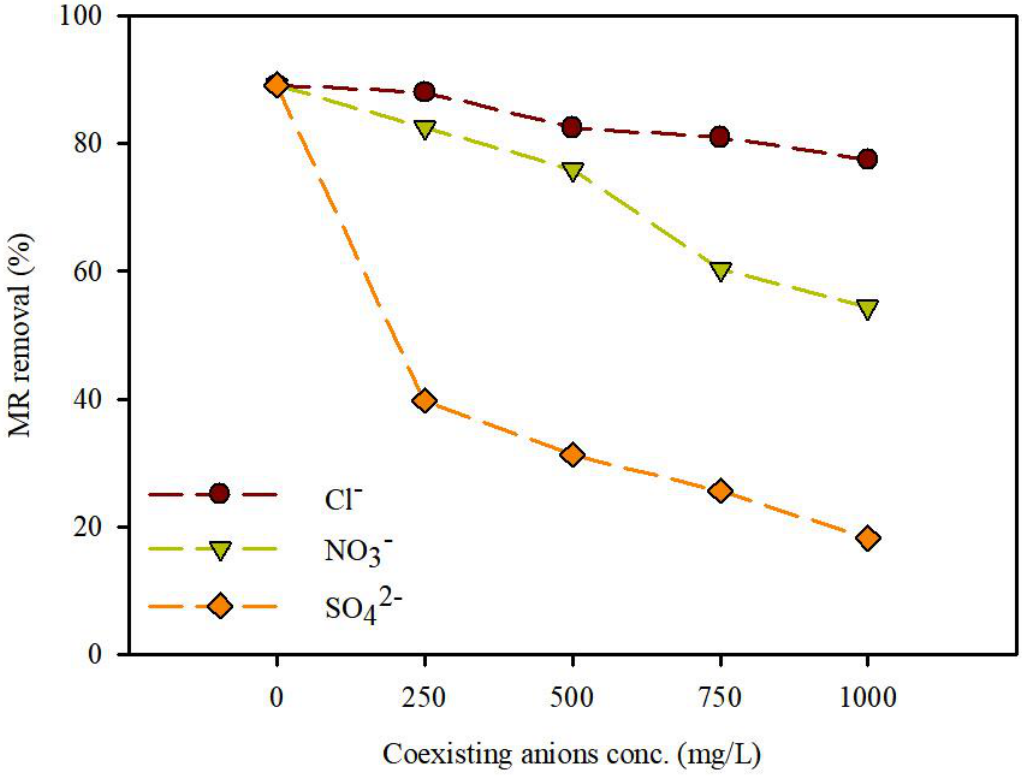
Figure 11. Effects of coexisting ions on MR adsorption by WFD/SA-PEI bead (initial concentration: 1000 mg/L; pH: 4.0).